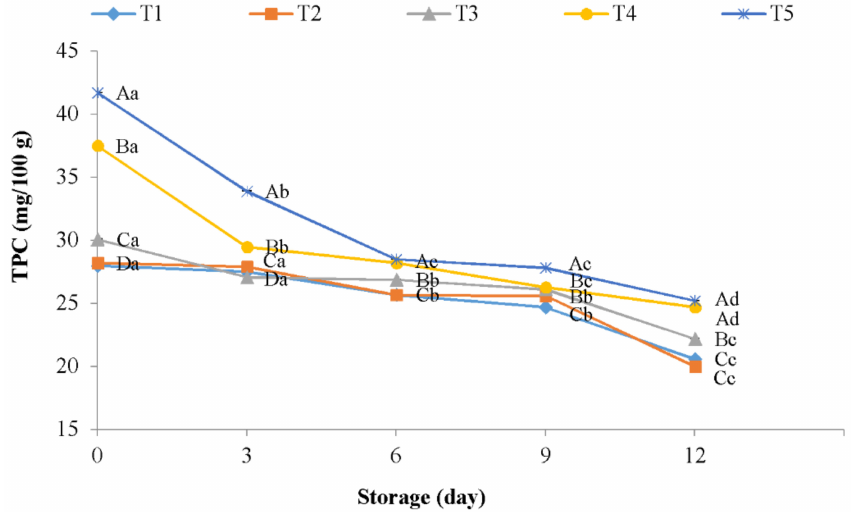
Figure 2. Total phenolic content of chicken meat coated with chitosan containing AFEOs during refrigerated storage. T1: Negative control; T2: Distilled water; T3: 1% CH coating + 500 ppm AFEOs; T4: 1% CH coating + 1000 ppm AFEOs; T5: 1% CH coating + 1500 ppm AFEOs. a–d Mean values during storage not followed by a common letter differ significantly ( p < 0.05). A–D Mean among meat samples not followed by a common letter differ significantly ( p <